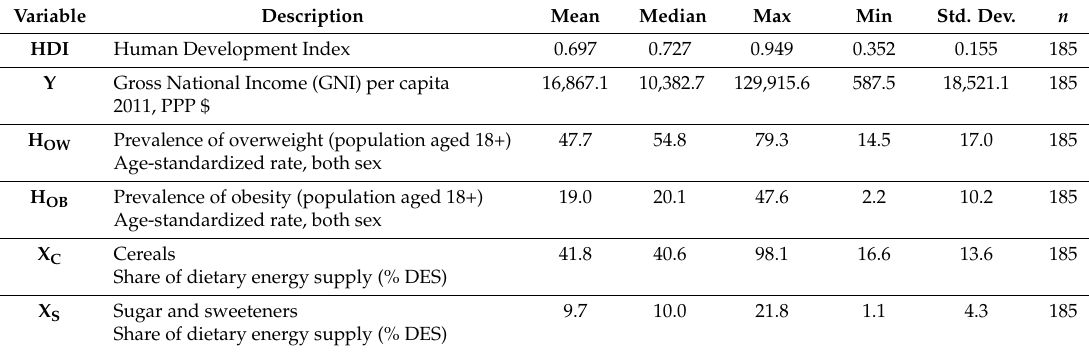
Table 1. Summary of statistics.